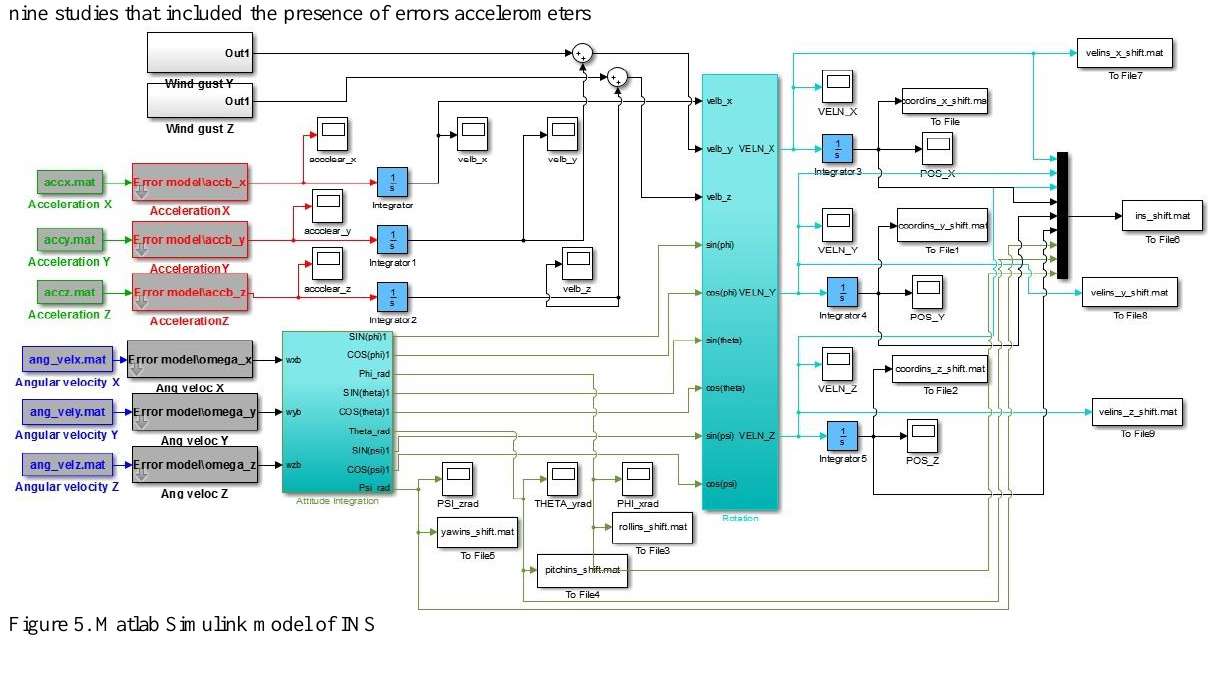
Figure 5. Matlab Simulink model of INS